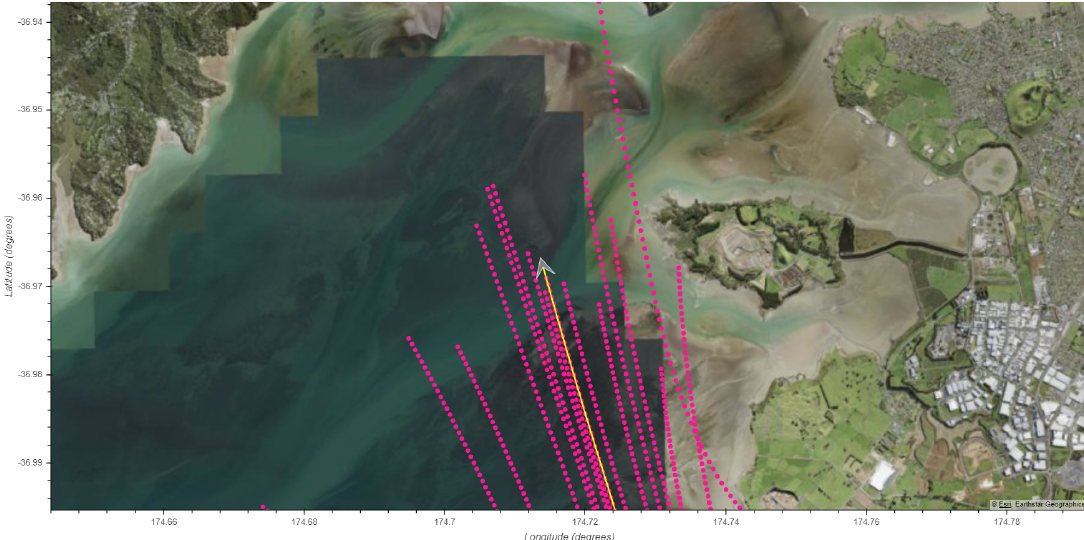
Figure 2. Snapshot of the flight visualisation tool currently in development. The visualisation shows an OpenSky flight (in yellow) along with the corresponding simulated specular point reflections (in pink) produced as the flight progresses. Video examples of the full flight can be found here (https://www. youtube.com/watch?v=GbmFFjoQtr8) and here